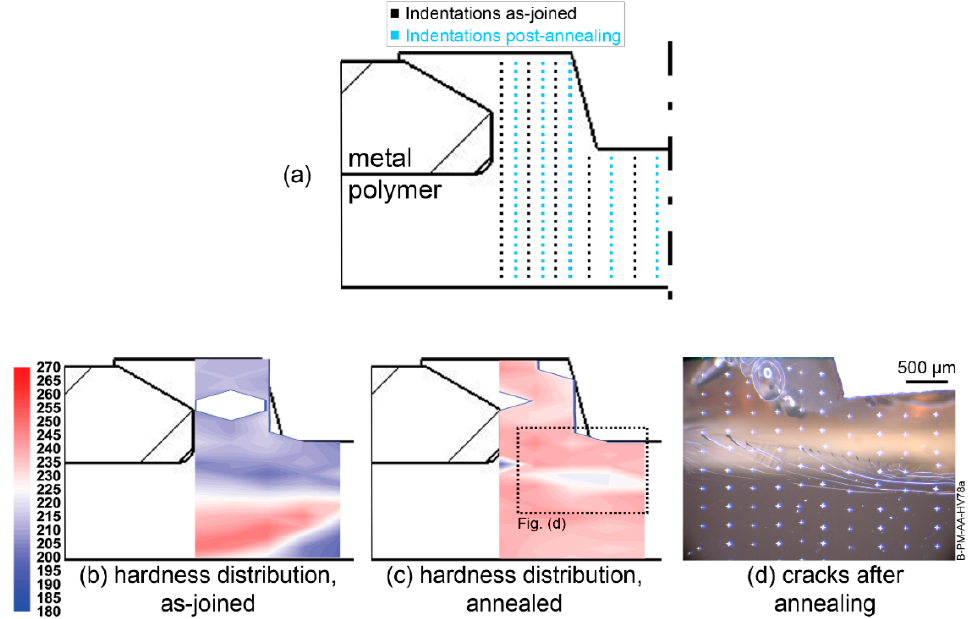
Figure 10. ( a ) Indentation positions for the annealing study; microhardness distribution maps from ( b ) as-joined and ( c ) annealed high-energy-input F-ICJ joint ( E work = 2339 J). ( d ) Cracks in the polymer after annealing.